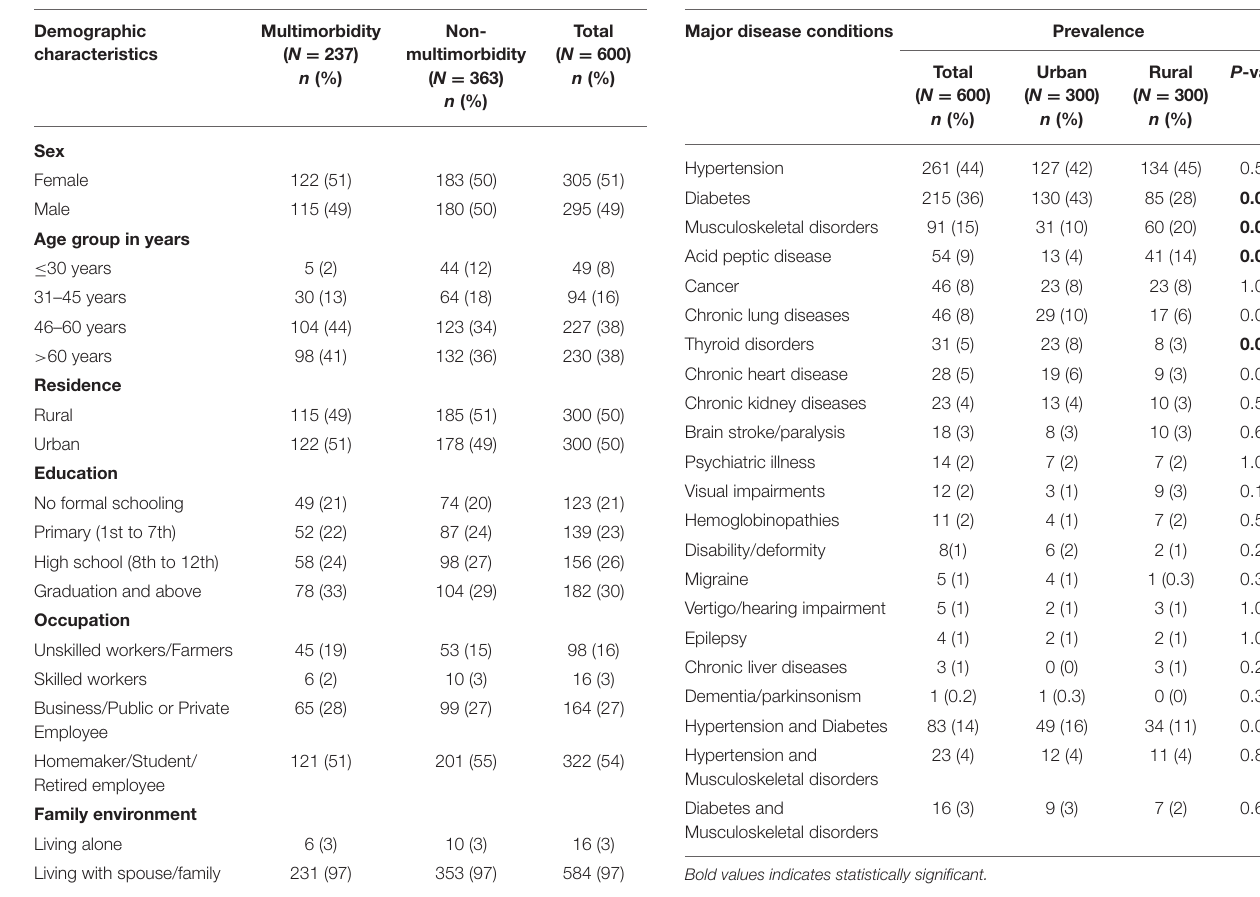
TABLE 1 | Socio-demographic characteristics of study participants. TABLE 2 | Profile of chronic